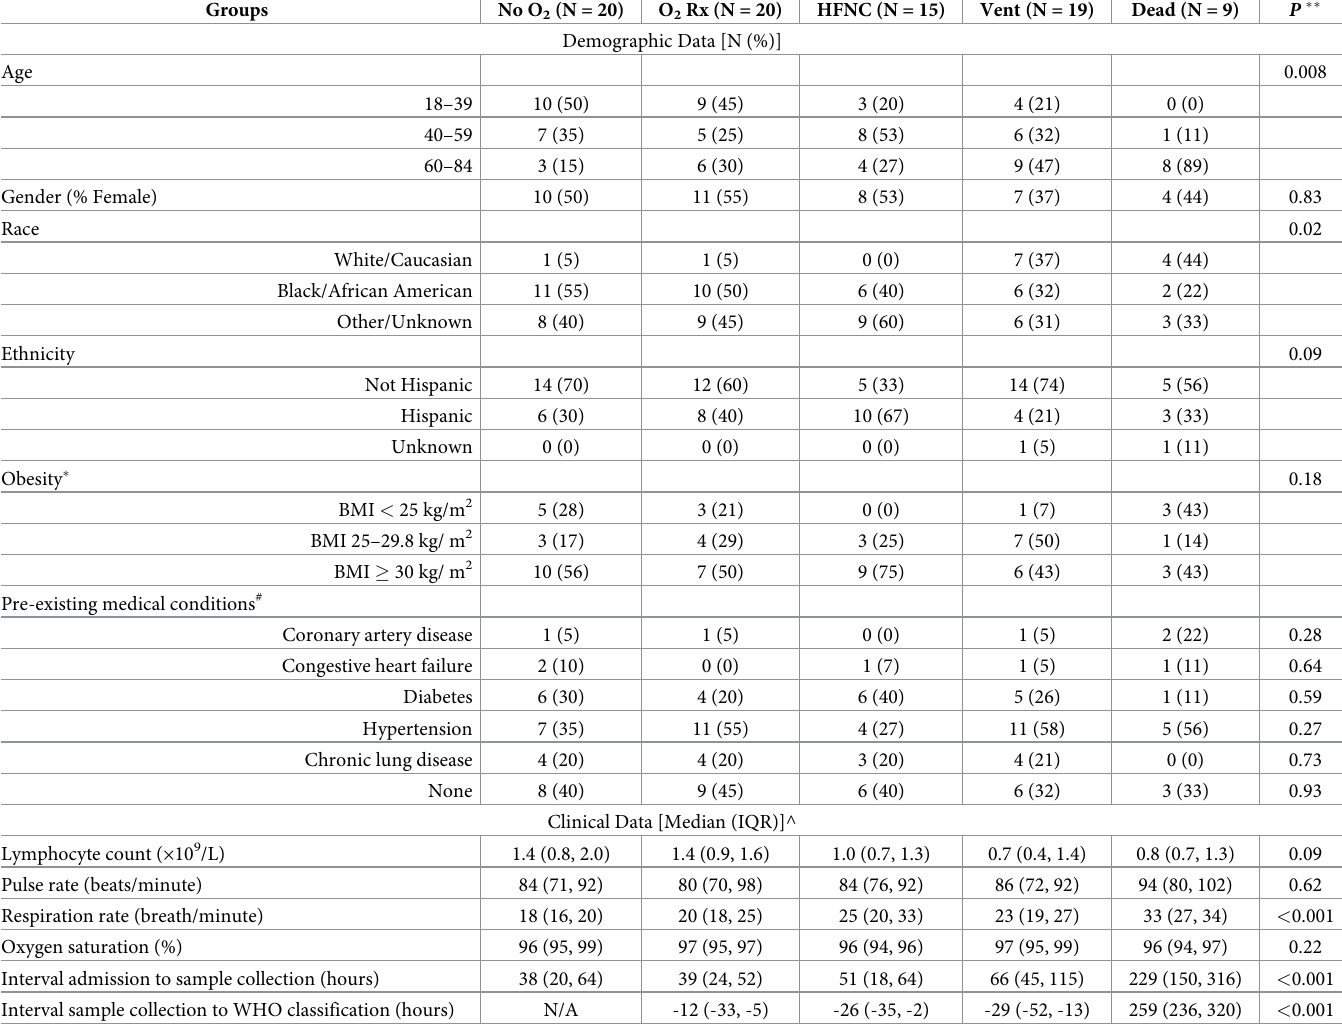
Table 1. Baseline demographics and clinical characteristics of the COVID-19 study cohort.